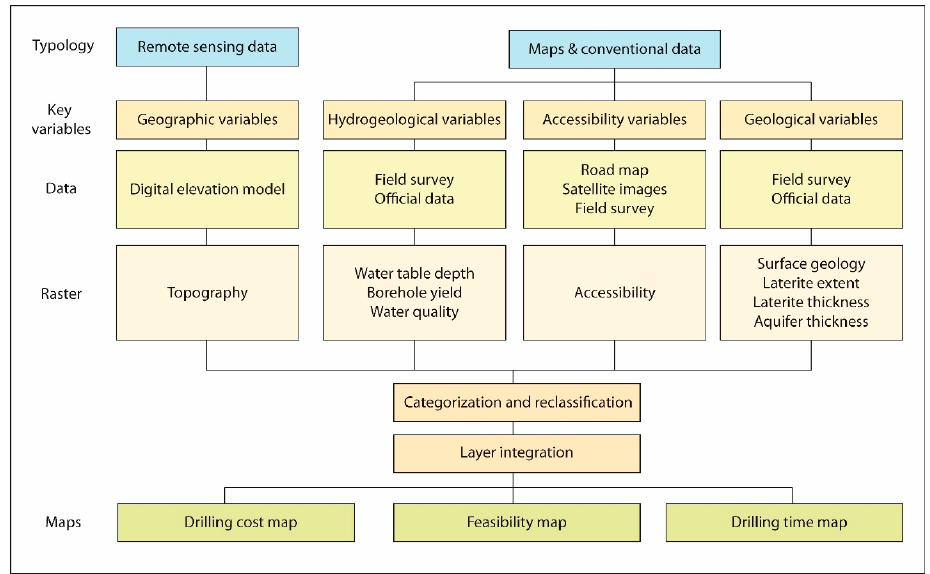
Figure 5. Structure of the GIS database, including data sources.